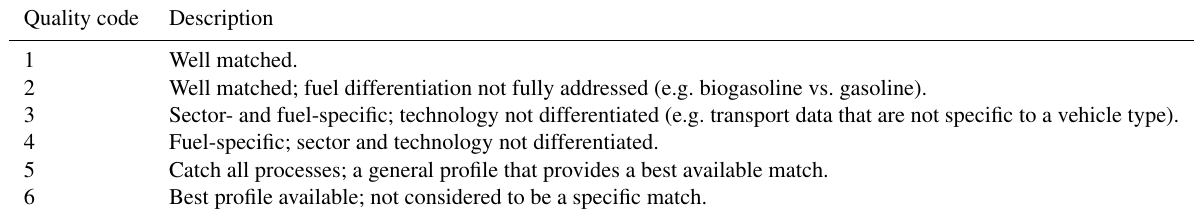
Table 1. The quality codes used to describe the quality of the match between the speciation profile and the EDGAR process. Quality code